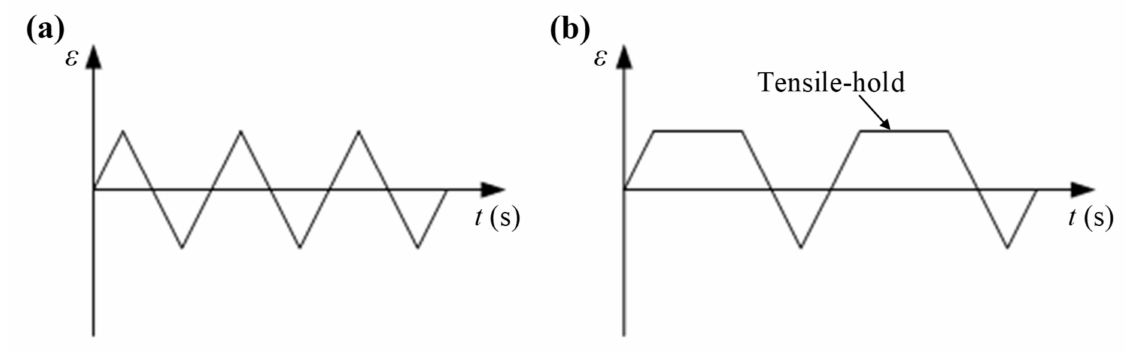
Figure 3. Illustration of the loading waveforms of ( a ) LCF test and ( b ) C–F test. Table 2. Test matrix for Inconel 625 alloy. Temp. ( ◦